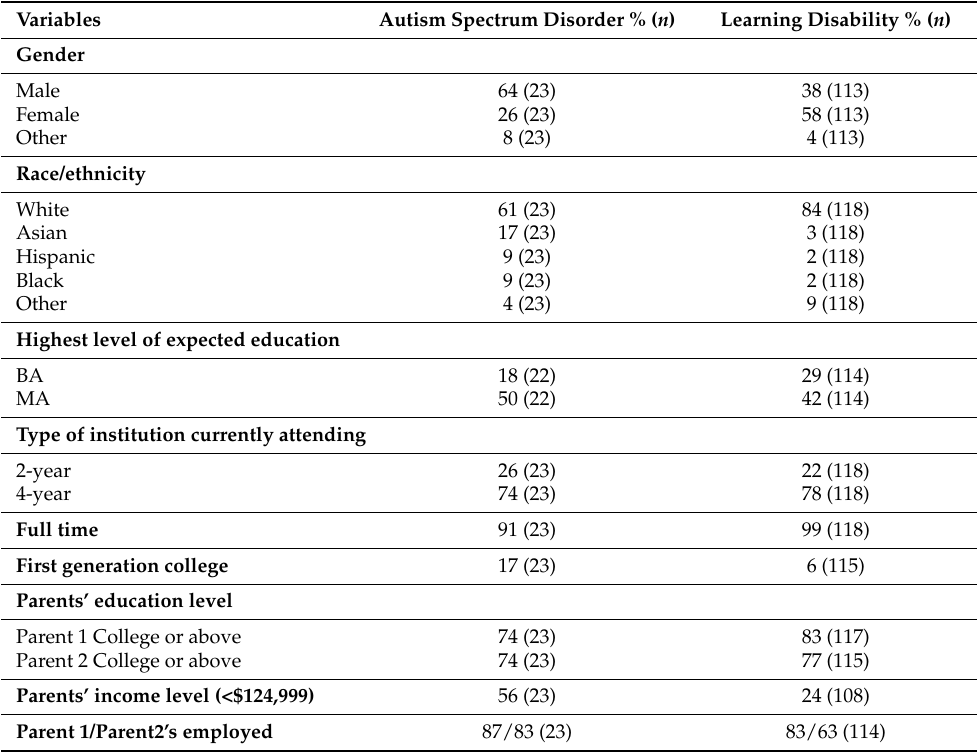
Table 1. Individual, Familial, & School Characteristics of First-year College Students with Autism Spectrum Disorders and Learning Disabilities.